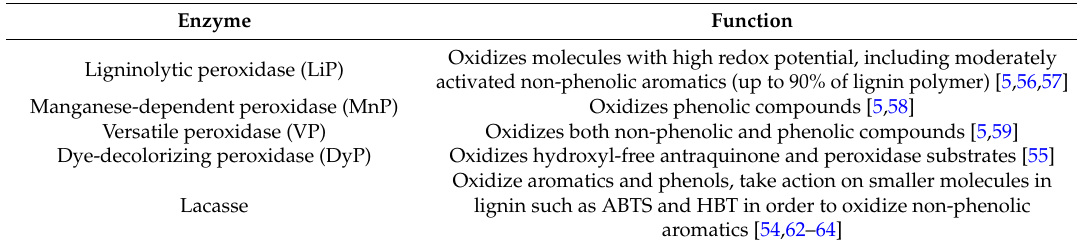
Table 3. Major enzyme families involved in lignin degradation.